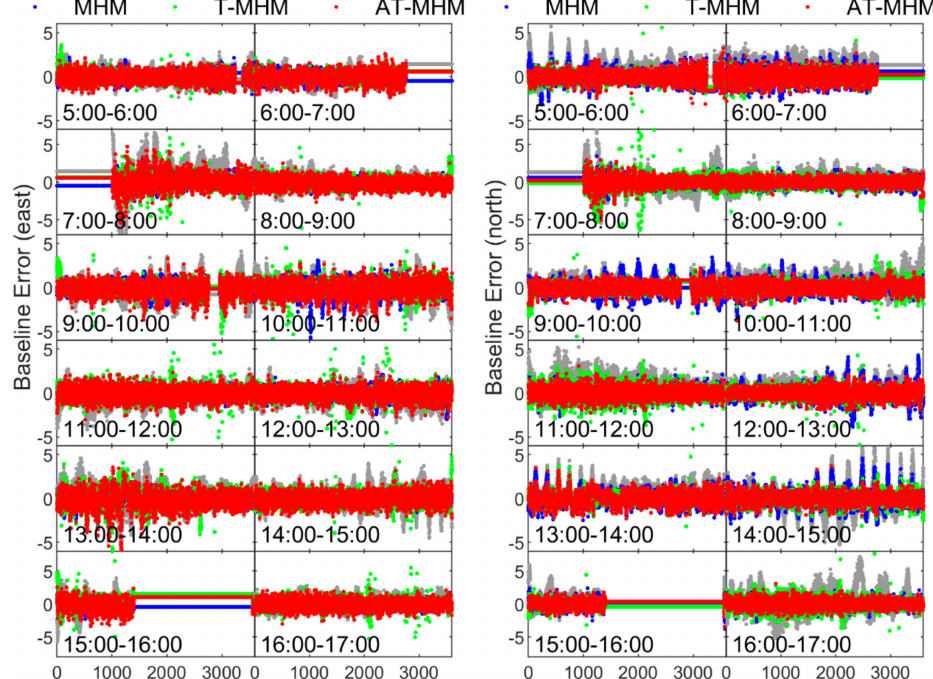
Figure 10. The results of the east ( left panel ) and north ( right panel ) directions before and after multipath correction on DOY 50. The color gray in the figure represents the uncorrected baseline solution of DOY 50. X-axis unit: second, Y-axis unit: meter.